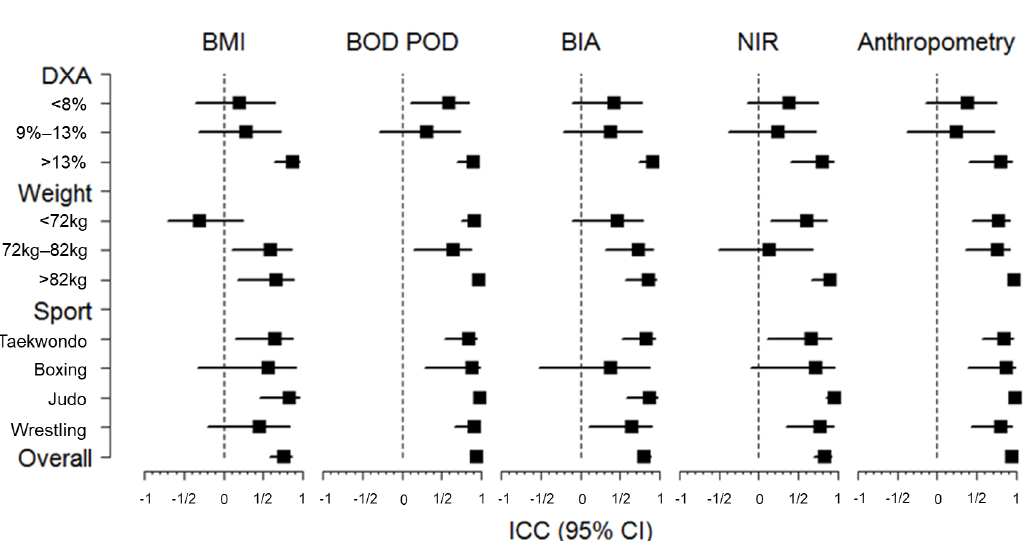
Figure 2. Forest plot: ICC (crude) and 95% confidence interval for the relationship between BMI and %BF (measured by BOD POD, BIA, NIR, and anthropometry) by subgroups (sport) or tertiles (%BF measured by DXA and weight). Abbreviations: ICC = intra-class correlation; CI = confidence inter- val; BMI = body mass index; %BF = percentage of body fat; BOD POD = air displacement plethys- mography; NIR = near-infrared interactance; BIA = bioelectrical impedance analysis; DXA = dual- energy X-ray absorptiometry.